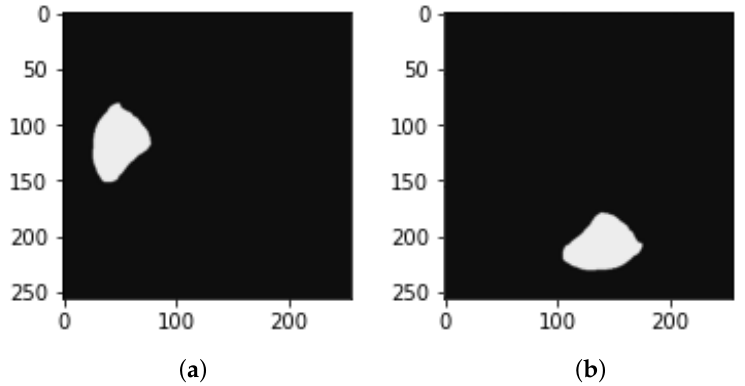
Figure 11. Image of mask ( a ) before rotation by 90 ◦ and ( b ) after rotation by 90 ◦